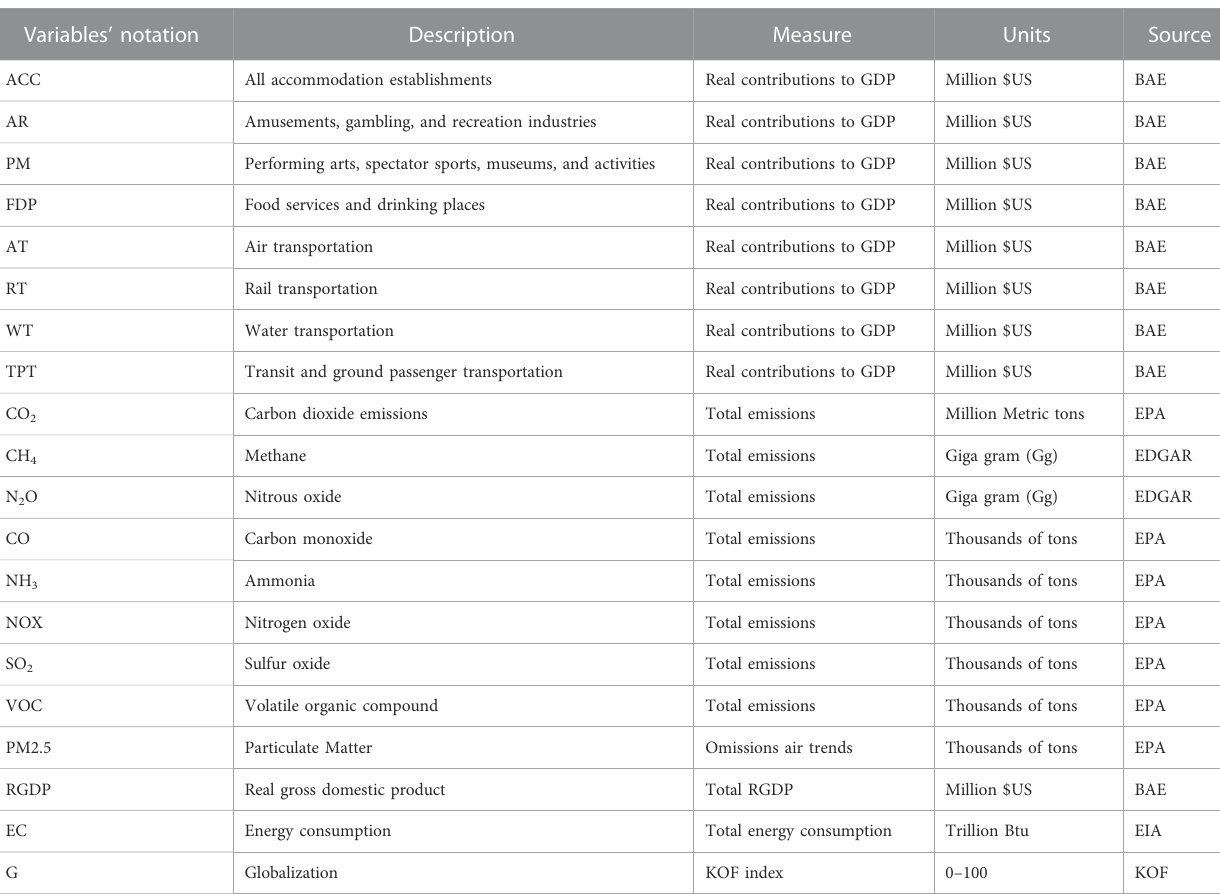
TABLE 1 Variables description. Variables ’